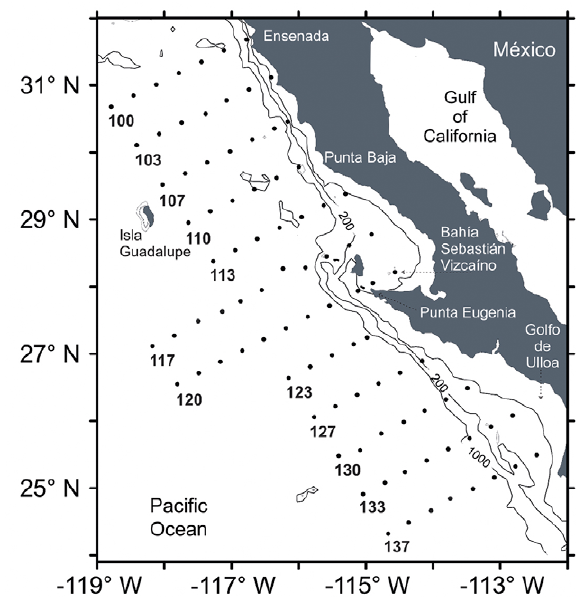
Fig. 1. – Basic station plan of the IMECOCAL programme on the western coast of the Baja California Peninsula. Contours indicate the bathymetry at 100 and 200 m depth.